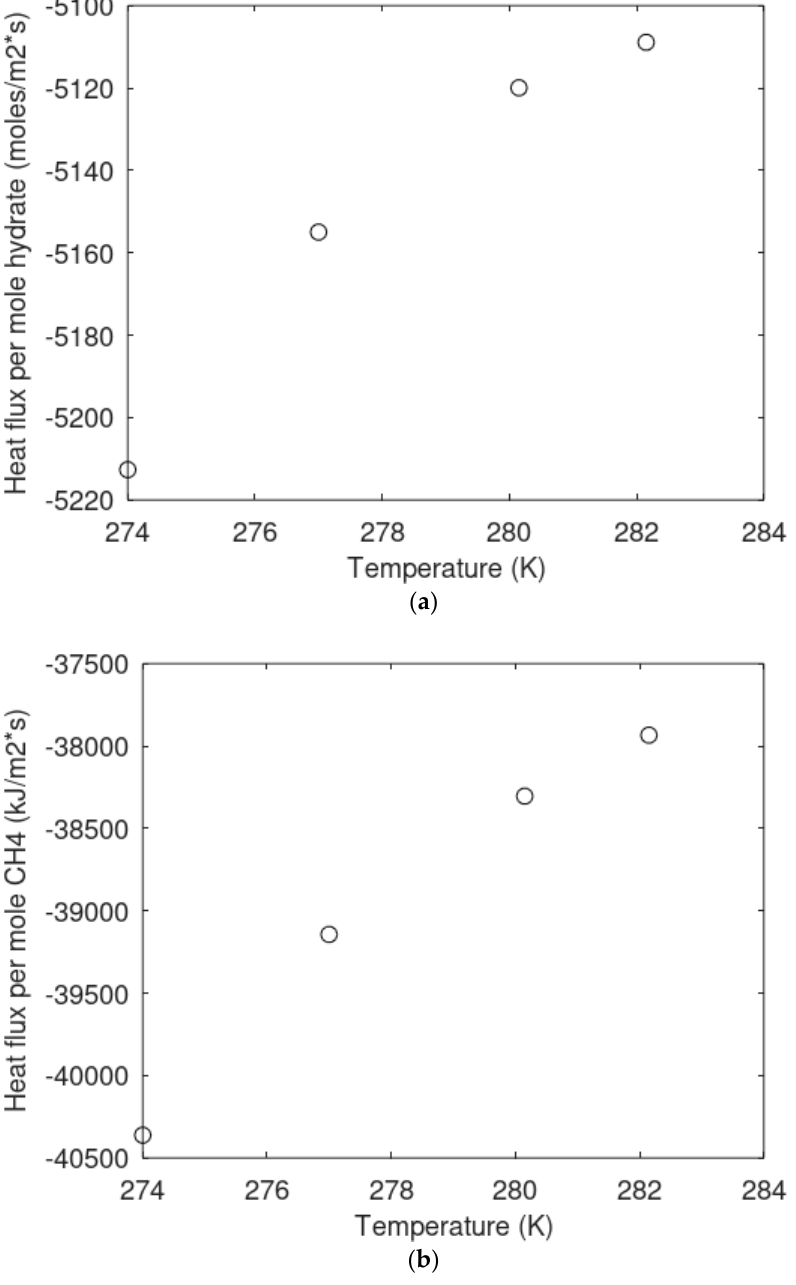
Figure 15. ( a ) Mass transport-controlled heat flux per mole hydrate. ( b ) Mass transport-controlled heat flux per mole CH 4 in the hydrate.